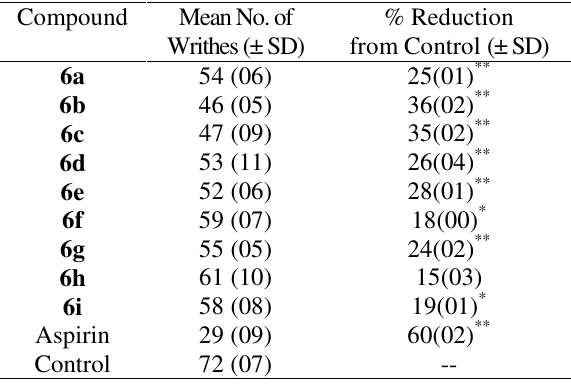
Table 3. Analgesic activity data of 6a-i. Compound Mean No. of % Reduction Writhes (± SD) from Control (± SD) 6a 54 (06) 25(01) ** 6b 46 (05) 36(02) ** 6c 47 (09) 35(02) ** 6d 53 (11) 26(04) ** 52 (06) 28(01)